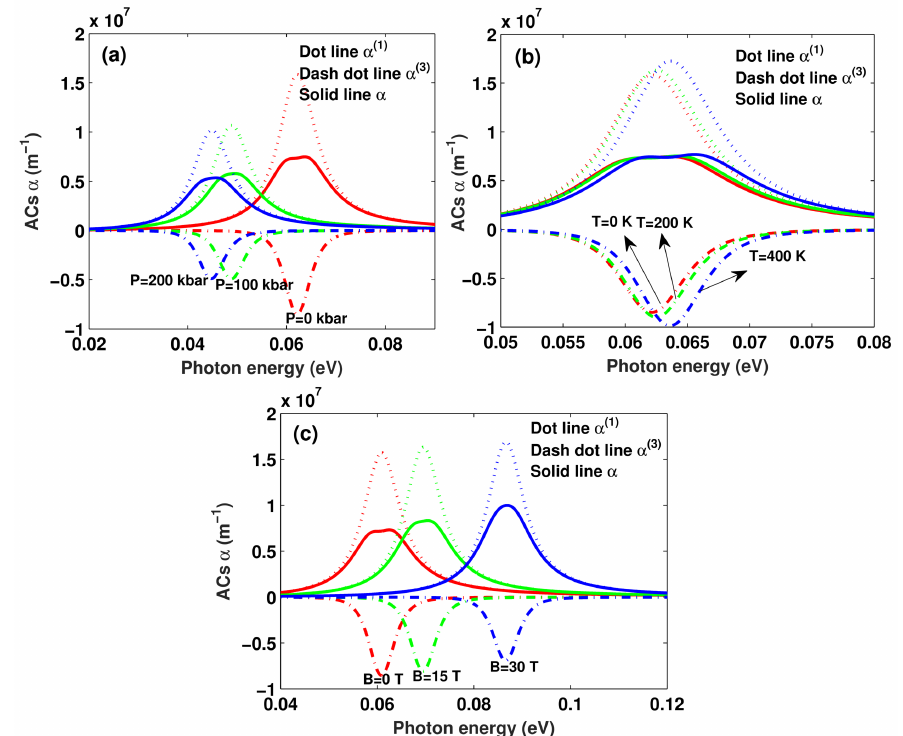
Figure 3. The OACs are depicted as a function of the incident photon energy for different hydrostatic pressure P ( a ), temperature T ( b ), and applied magnetic field B ( c ) with I = 0.6 MW/cm 2 and well width L = 8